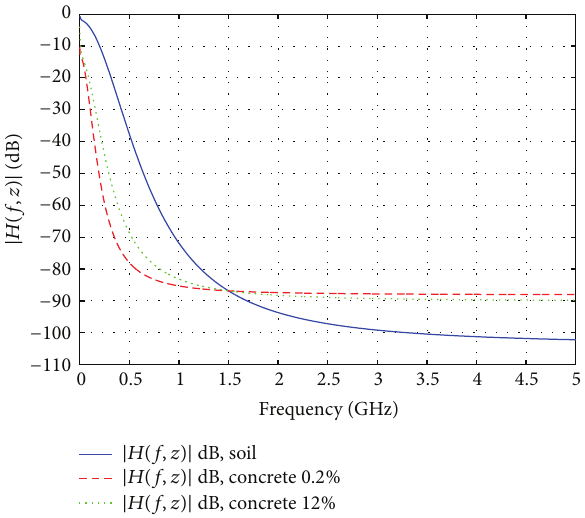
Figure 2: Frequency response assuming: (a) soil and (b)